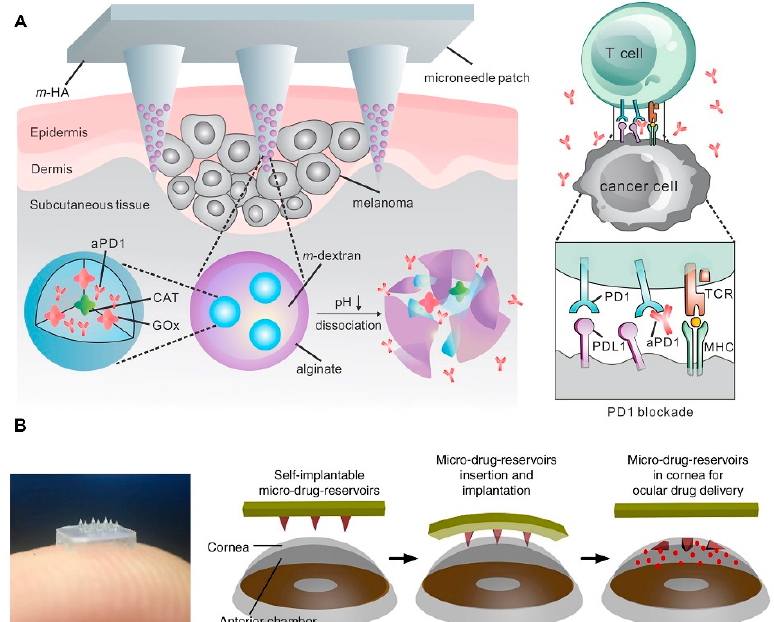
Figure 7. ( A ) Schematic illustration of GOx and catalase (CAT) assisted anti-PD-1 delivery by nanoparticle loaded dissolving MN (reproduced with permission from the authors of [141]). ( B ) Schematic illustration of self-implantable double-layered MN in ocular application and real product photograph. (reproduced with permission from the authors of [144] ).